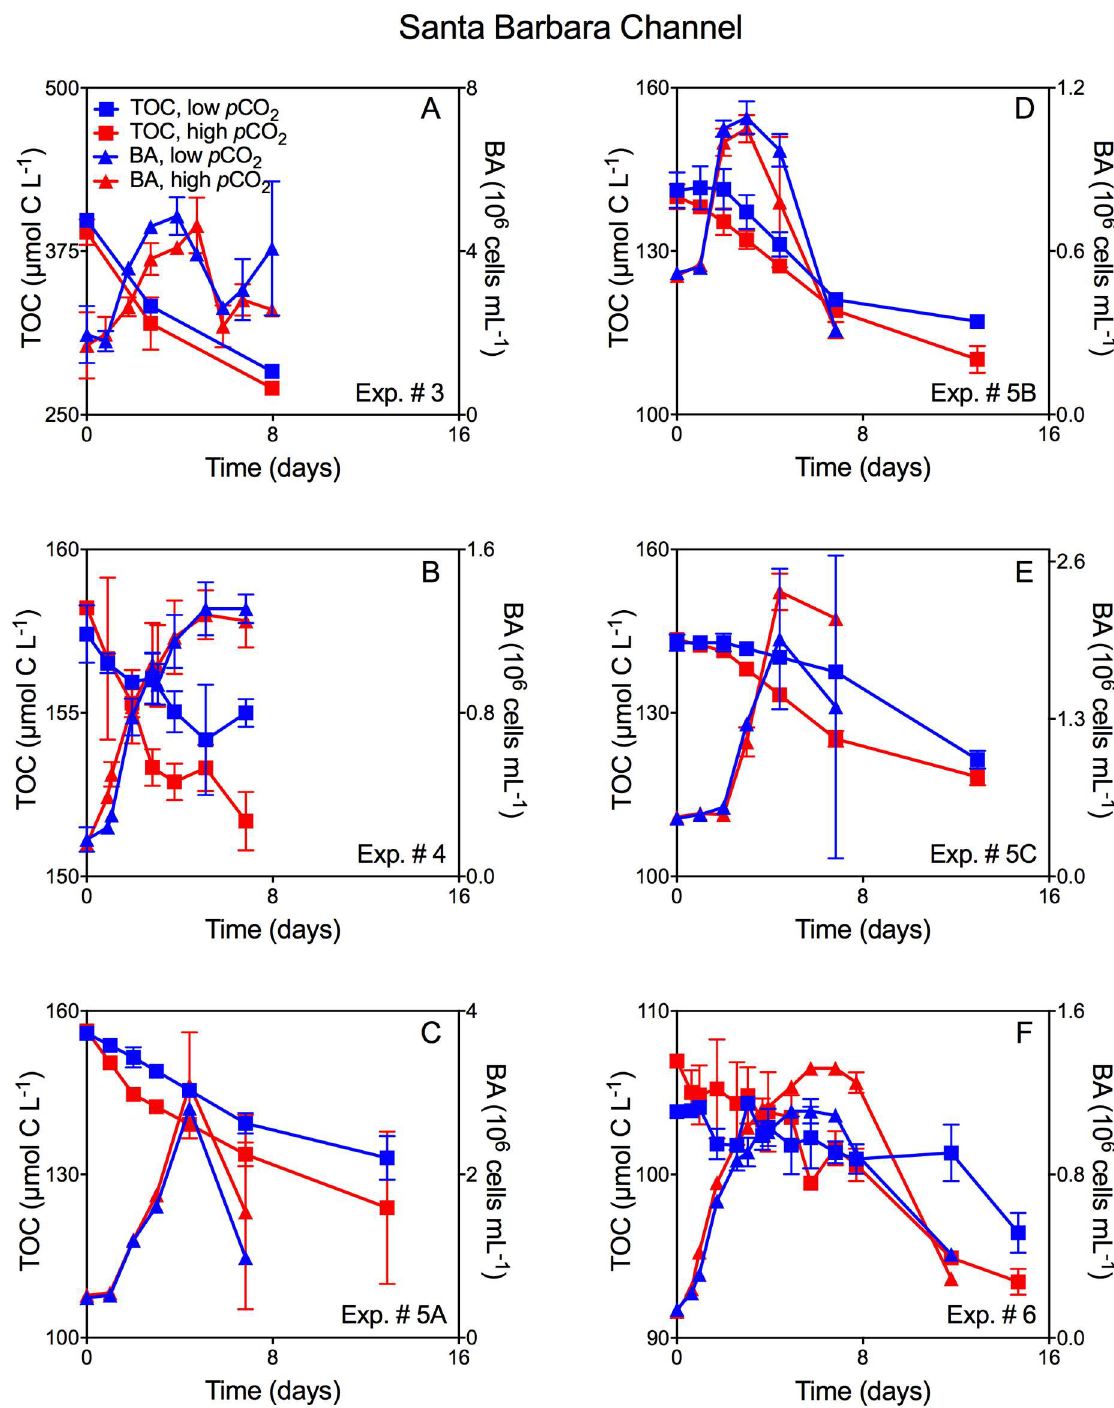
Fig 2. Mean TOC concentration and mean bacterioplankton abundance for Santa BarbaraChannel phytoplankton-DOC experiments. Mean TOC concentration ( ± SD) and mean bacterioplankton abundance (BA; ± SD) averaged across duplicate incubations through time and as a function of p CO 2 for natural bacterioplankton assemblagesin the Santa BarbaraChannel experiments incubatedwith: A: D . fragilissimus -derivedDOC, Exp. #3; B: T . weissflogii -derivedDOC, Exp. #4; C: T . weissflogii - derived DOC, Exp. #5A; D: C . socialis- derived DOC, Exp. #5B; E: A . glacialis -derived DOC, Exp. #5C; F: E . huxleyi -derivedDOC, Exp. #6. Red denoteselevated p CO 2, whileblue denoteslow (250 ppm) p CO 2 . Squaresrepresent TOC ( μ molC L -1 ) while trianglesdenotebacterioplankton abundance(10 6 cells mL -1 ) over the course of the incubation.